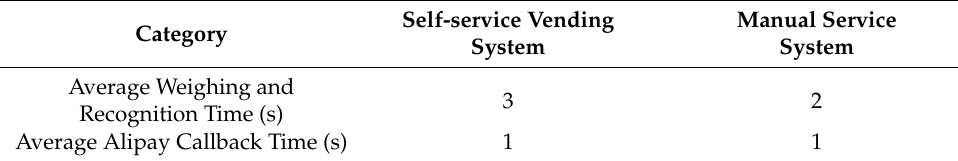
Table 5. The time comparison of different sales